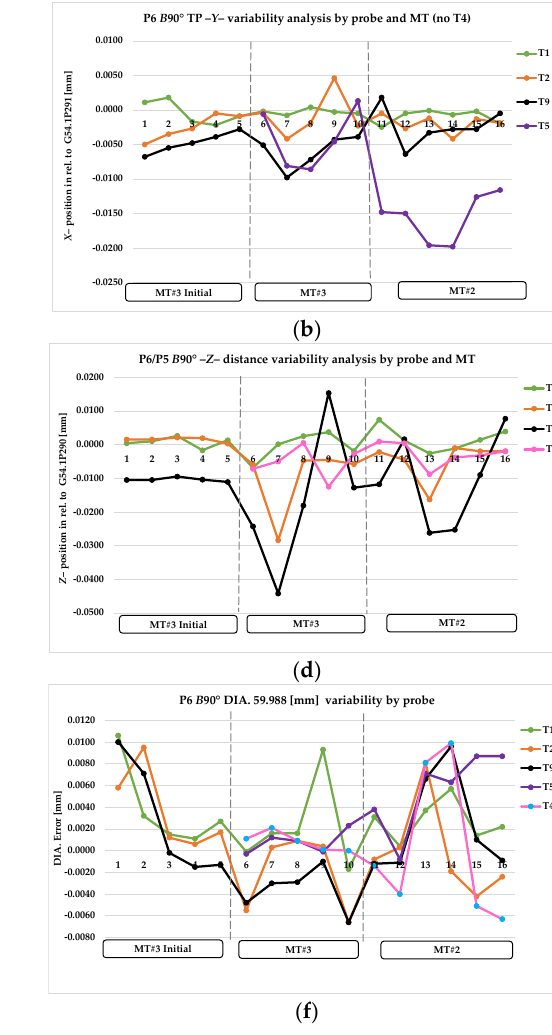
Figure 12. Analysis of P6 area measurement for probes T1, T2, T9, T5 ( B 90° head), and T4 ( B 0° head): ( a ) variability of hole true position— Y direction, all probes; ( b ) variability of hole’s true position— Y direction, T6 probe error hidden; ( c ) variability of hole’s true position— Z direction; ( d ) variability of Z —direction distance; ( e ) variability of X —direction distance; ( f ) variability of master hole size.